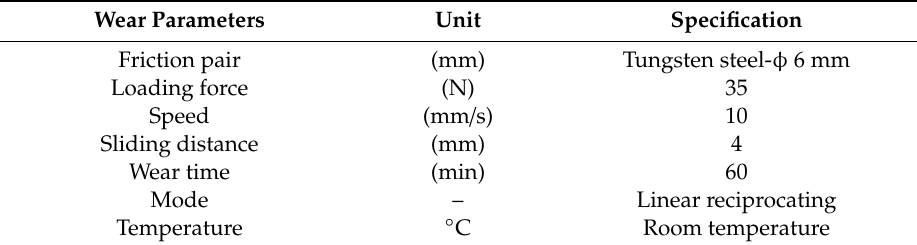
Table 2. Friction and wear parameter table.